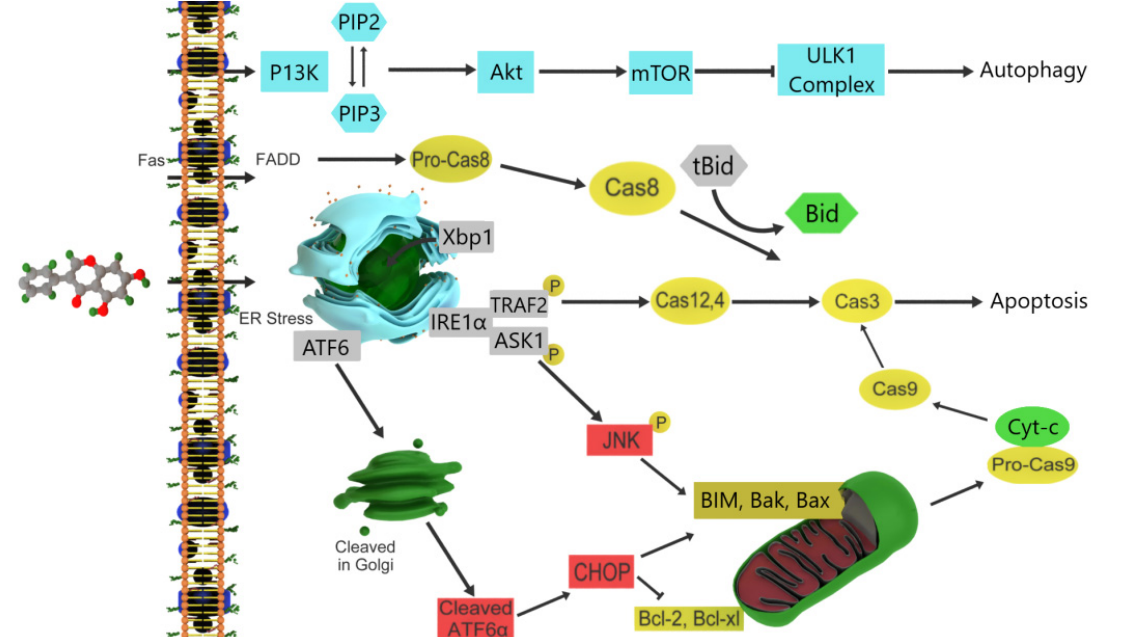
Figure 4. Mechanism of pinocembrin induction of apoptosis in cancer cells. In the intrinsic pathway, the expression of the pro-apoptotic proteins B-cell lymphoma-2 (Bcl-2) associated X protein, Bcl-2 homologous antagonist/killer, and Bcl-2-like protein 11 increases and that of the anti-apoptotic proteins Bcl-2 and Bcl-extra-large decreases. Cytochrome c translocates from the mitochondria to the cytosol, leading to apoptosis. In the extrinsic pathway, pinocembrin leads to apoptosis via the Fas-associated protein death domain/caspase-8/caspase-3 signaling pathway.